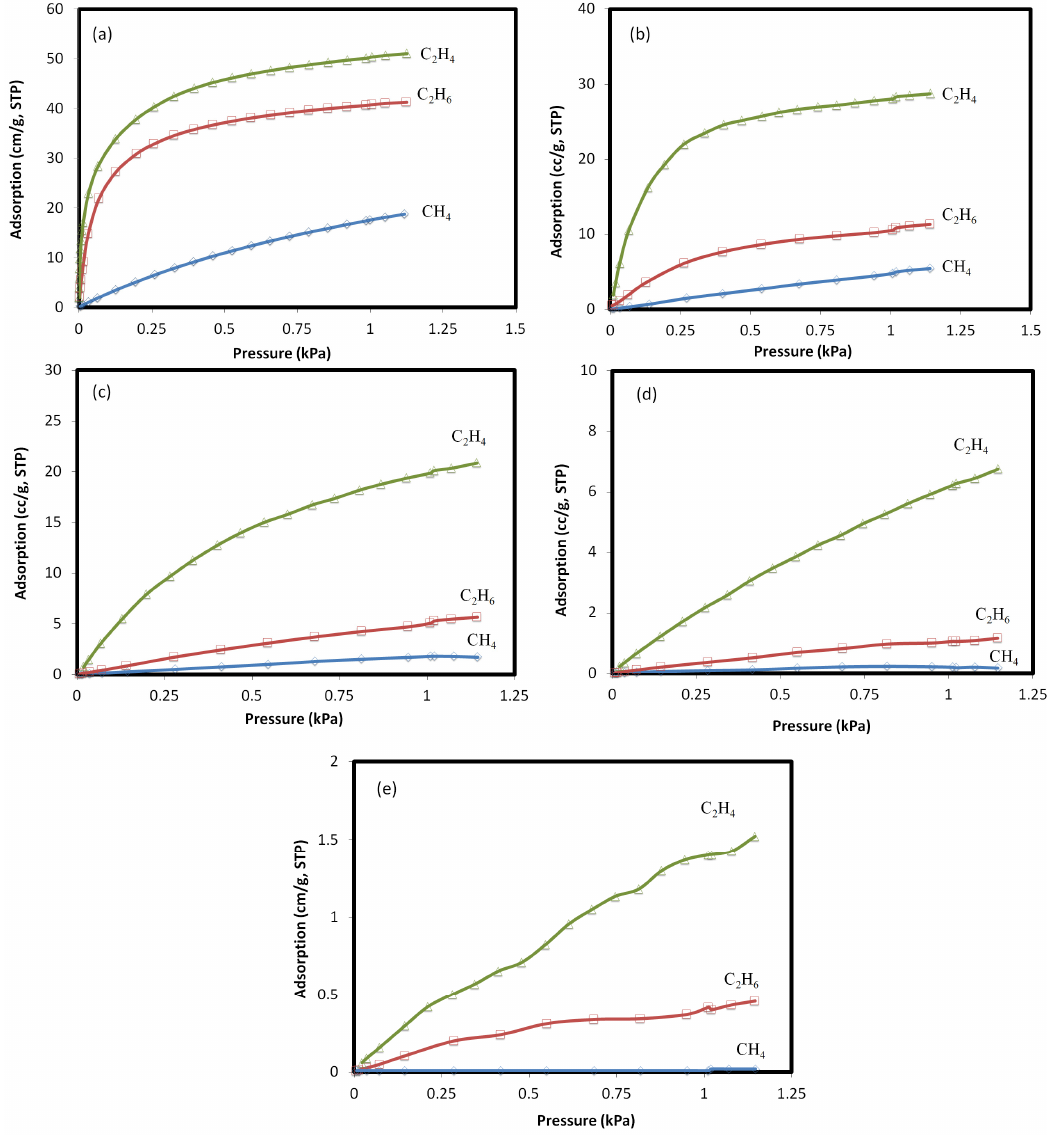
Figure 2. Adsorption isotherms for ethylene, ethane, and methane on natural clinoptilolite at ( a ) 25 °C; ( b ) 100 °C; ( c ) 200 °C; ( d ) 300 °C, and ( e ) 400 °C.